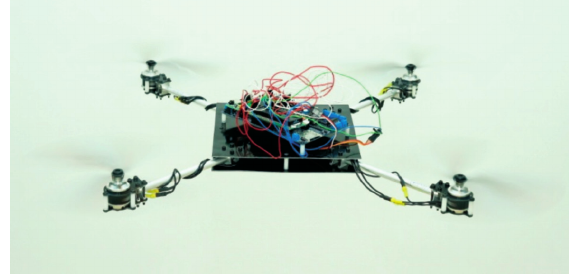
Fig. 4. The prototype